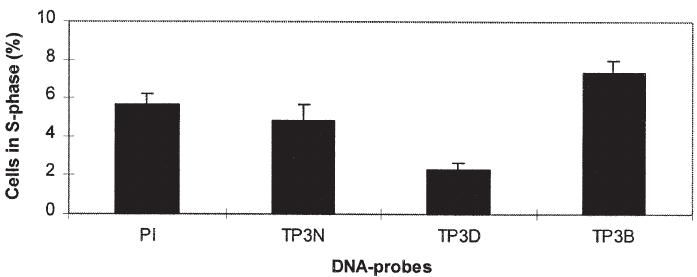
Fig. 1. Cells in S-phase measured with PI or TP3 48 h following tape stripping (TP3N: keratin 10-negative population, TP3D: keratin 10-dim population, TP3B: keratin 10-bright population).